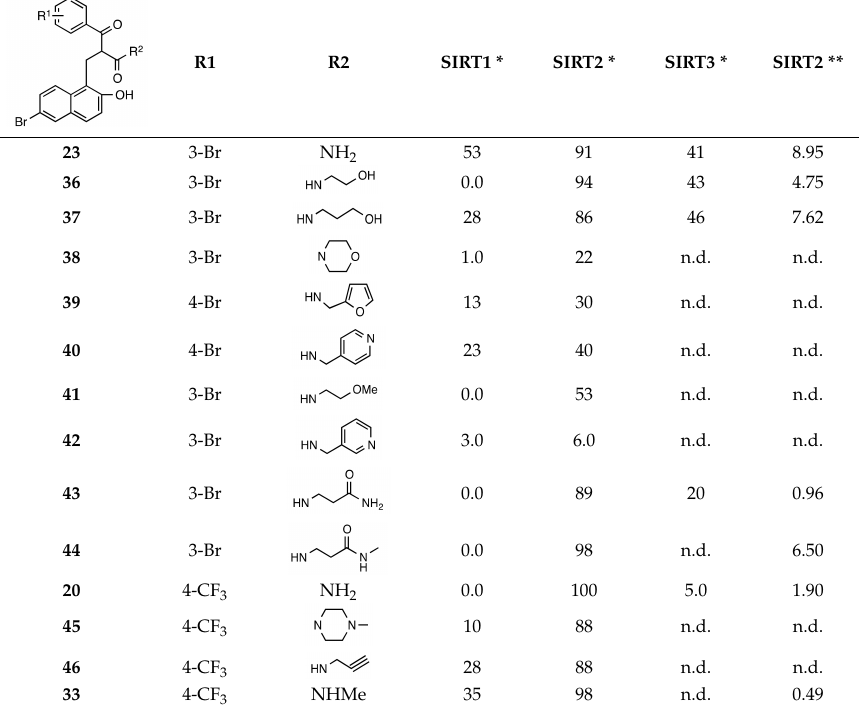
Table 3. Optimization of the sidechain (R 2